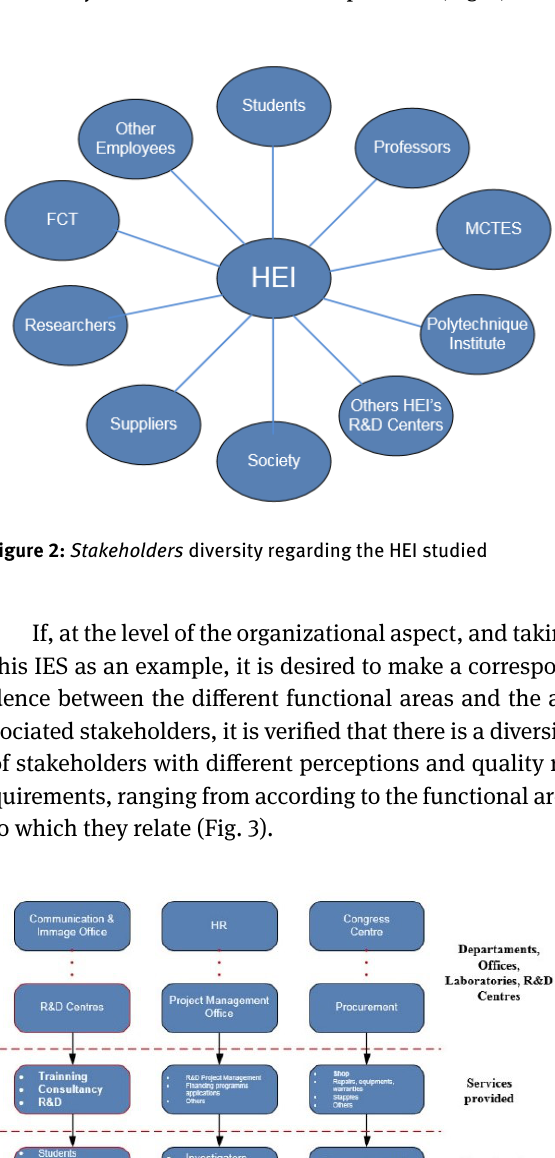
Figure 3: Example of relationship between functional areas and the stakeholder’s diversity regarding an HEI